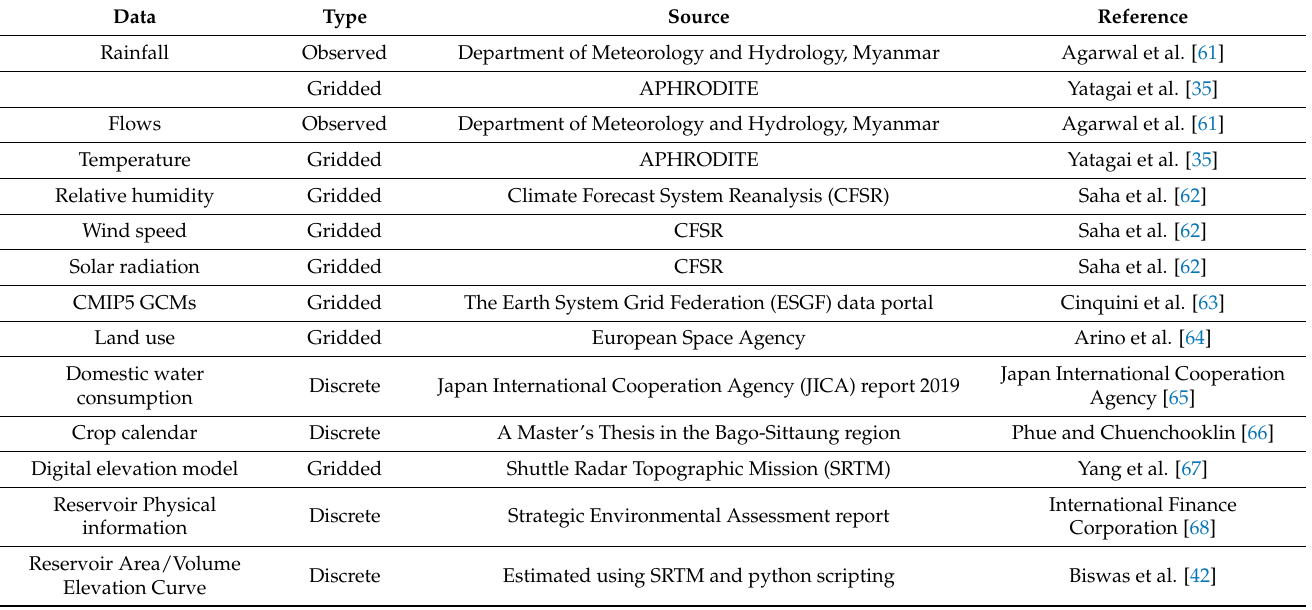
Table 1. Data used in this study and their